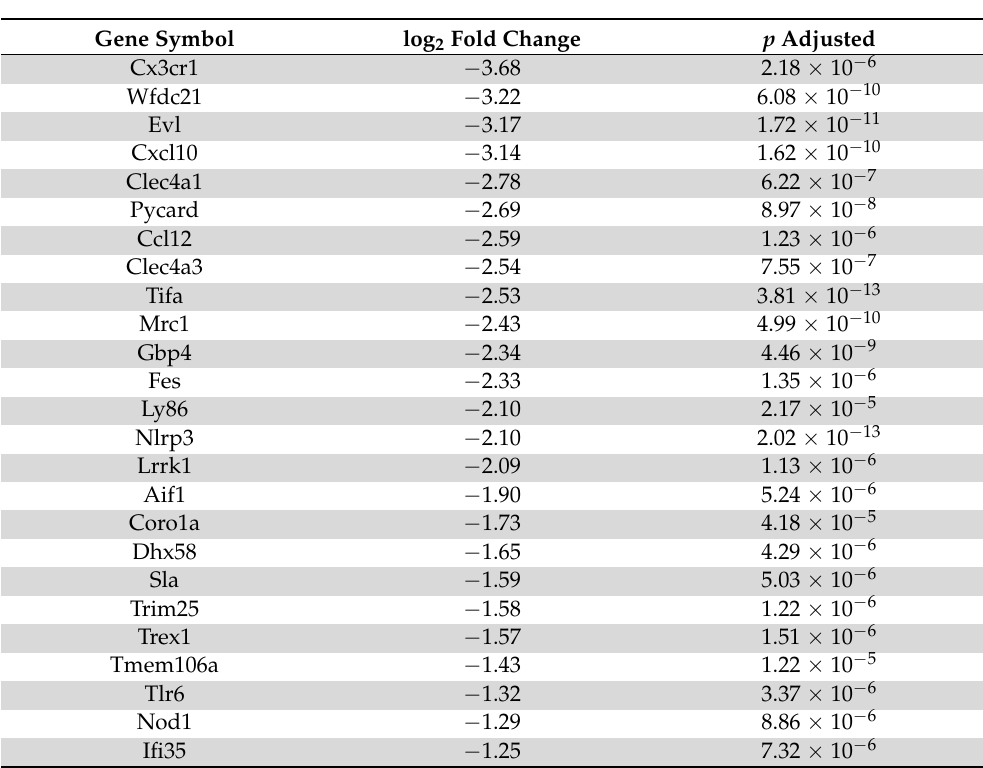
Table 4. Innate immune